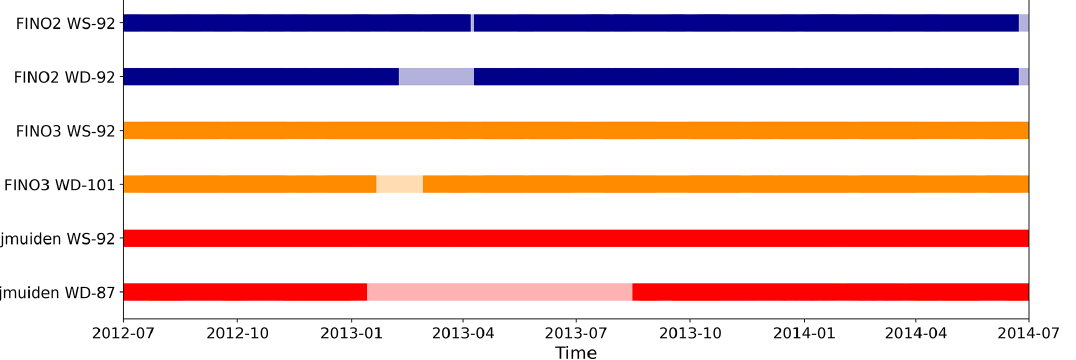
Figure 2. Data availability at the three masts after filling in the pre-processing step. The light colours indicate values that were filled by measurements from lower heights as described above.